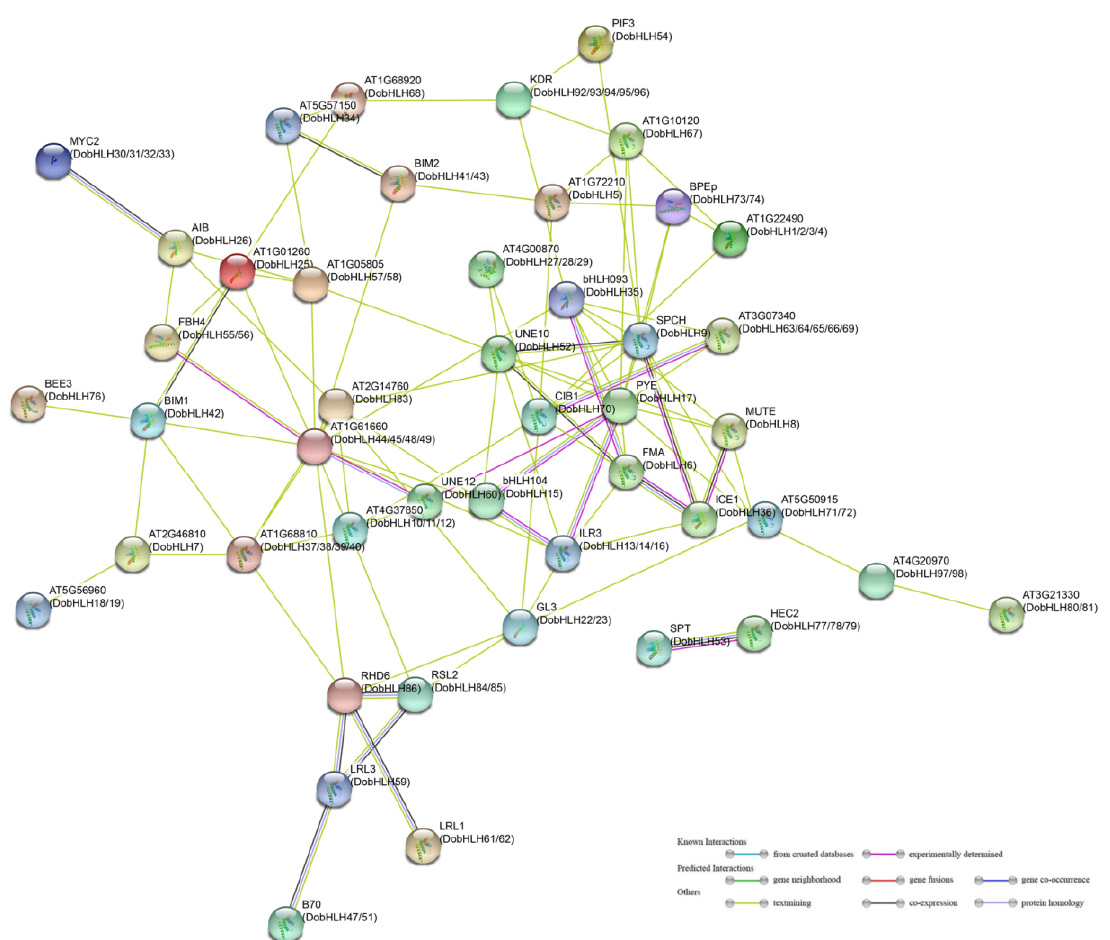
Figure 7. The predicted network of protein–protein interactions between DobHLHs by STRING. The different colors represent different types of interactions. Arabidopsis bHLH names are marked while their homologs in D. officinale are in parentheses.